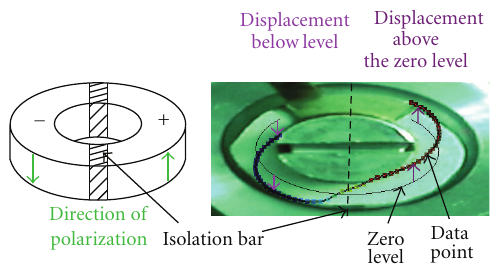
Figure 6: Displacement of one new piezoceramic ring.